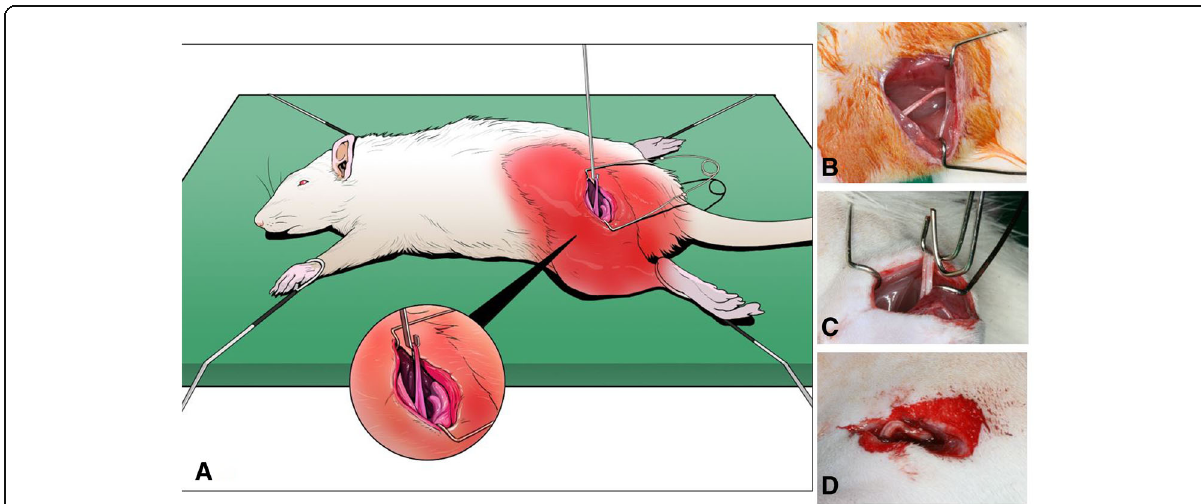
Fig. 1 Surgical procedure for traction injury of the sciatic nerve of a rat. ( a schematic drawing of the experiment, b exposure of the sciatic nerve, c traction injury with hook wire, d Elongated nerve after traction